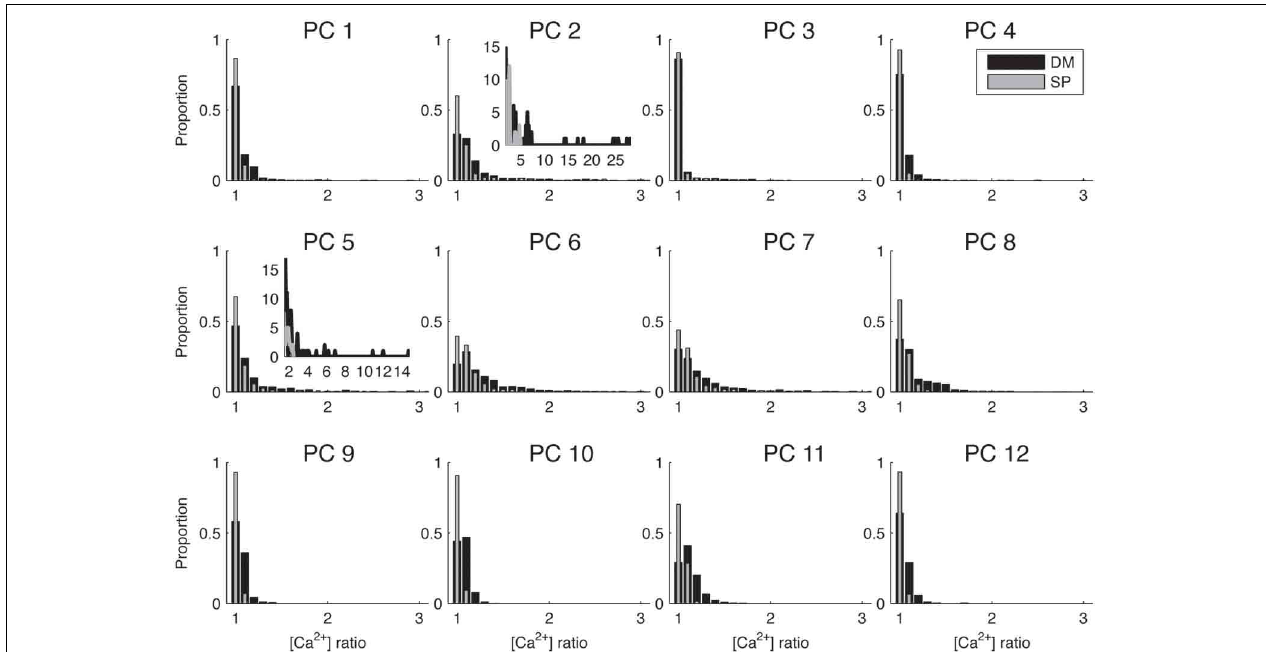
make the differences between cells more visible only the range of ratios 1–3 is shown, for the two cells that have significantly larger ratios the full distribution is shown in the inset. PC1 is shown in Figure 2 . Integrated Ca 2 + was computed for 20ms around the first peak of Ca 2 + transients for all